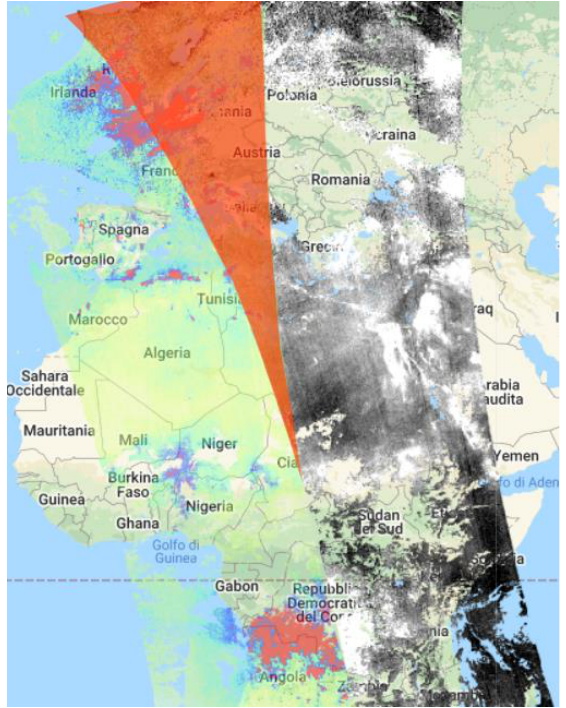
Figure 3. Snapshot showing two overlapping S5P consecutive orbits: red area highlights the overlap that increases at higher latitudes, embracing the study area.